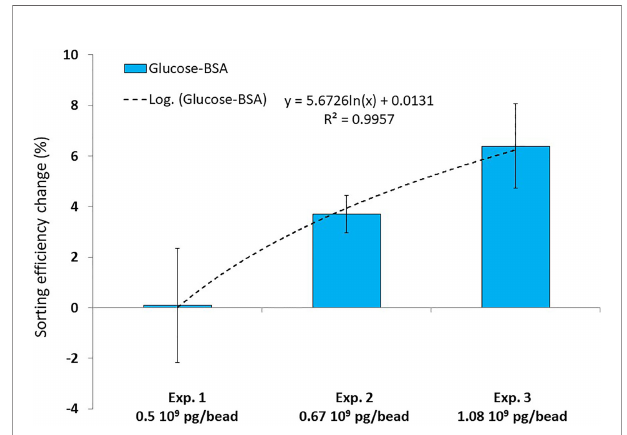
FIGURE 5 | Percent change in sorting ef fi ciency (mean ± standard deviation, n = 12 per data point) for microspheres coated with different quantities of glucose-BSA. The dashed line and equation represent the best fi